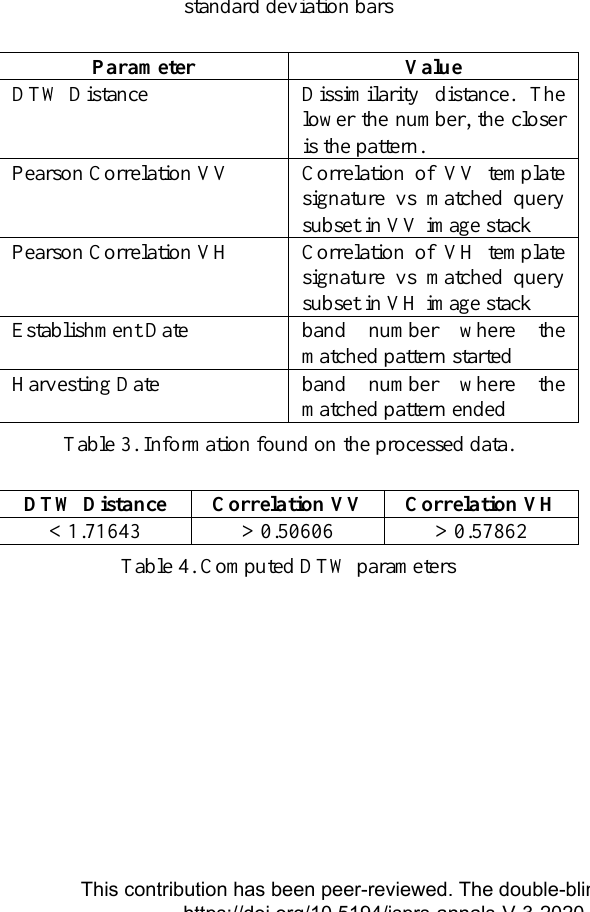
Figure 4. Sugarcane temporal signature for VV and VH with